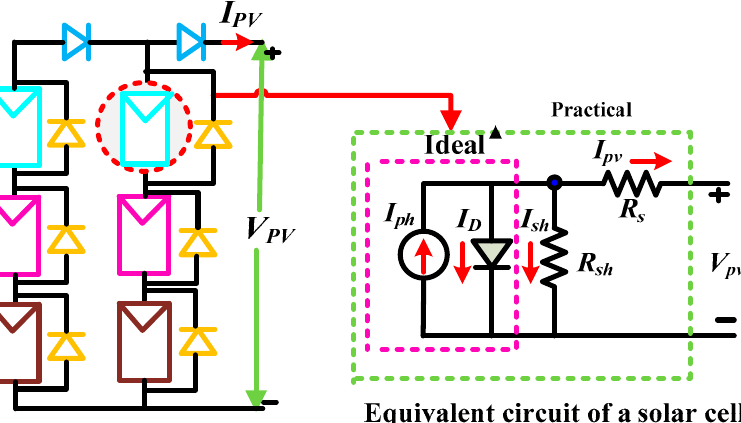
Figure 1. Equivalent circuit representation of single-diode model.